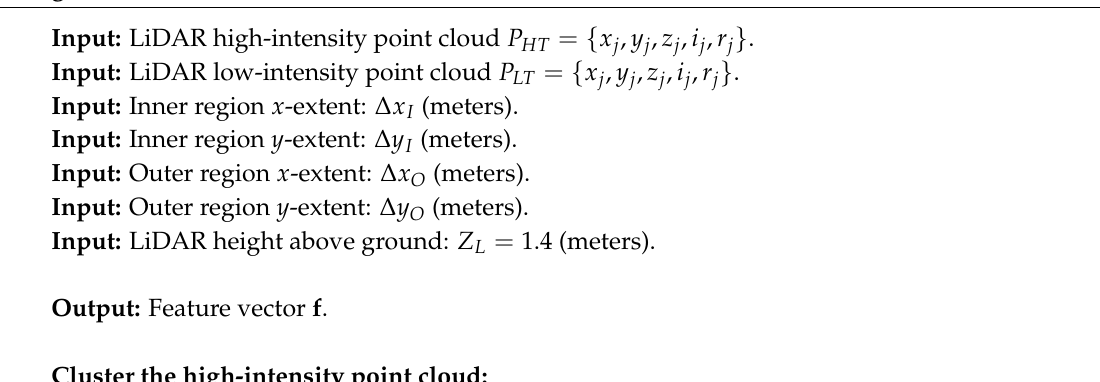
Algorithm 3: LiDAR feature